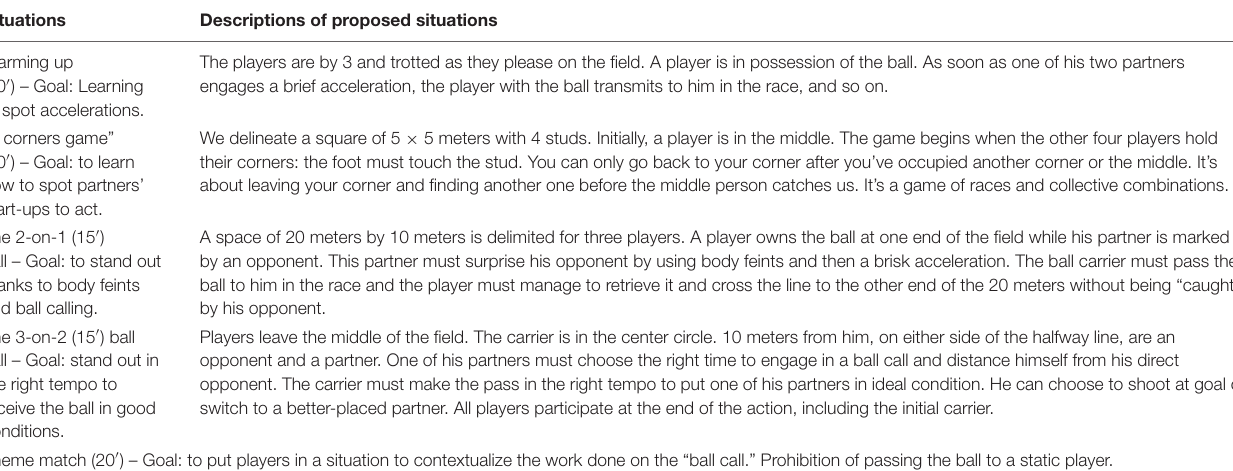
TABLE 3 | Description of the situations offered to players aged 8–9 during a training session to decode the praxemes on the theme of “ball calling.” A traditional game called “4 corners game” also allows you to work on this theme. Situations Descriptions of proposed